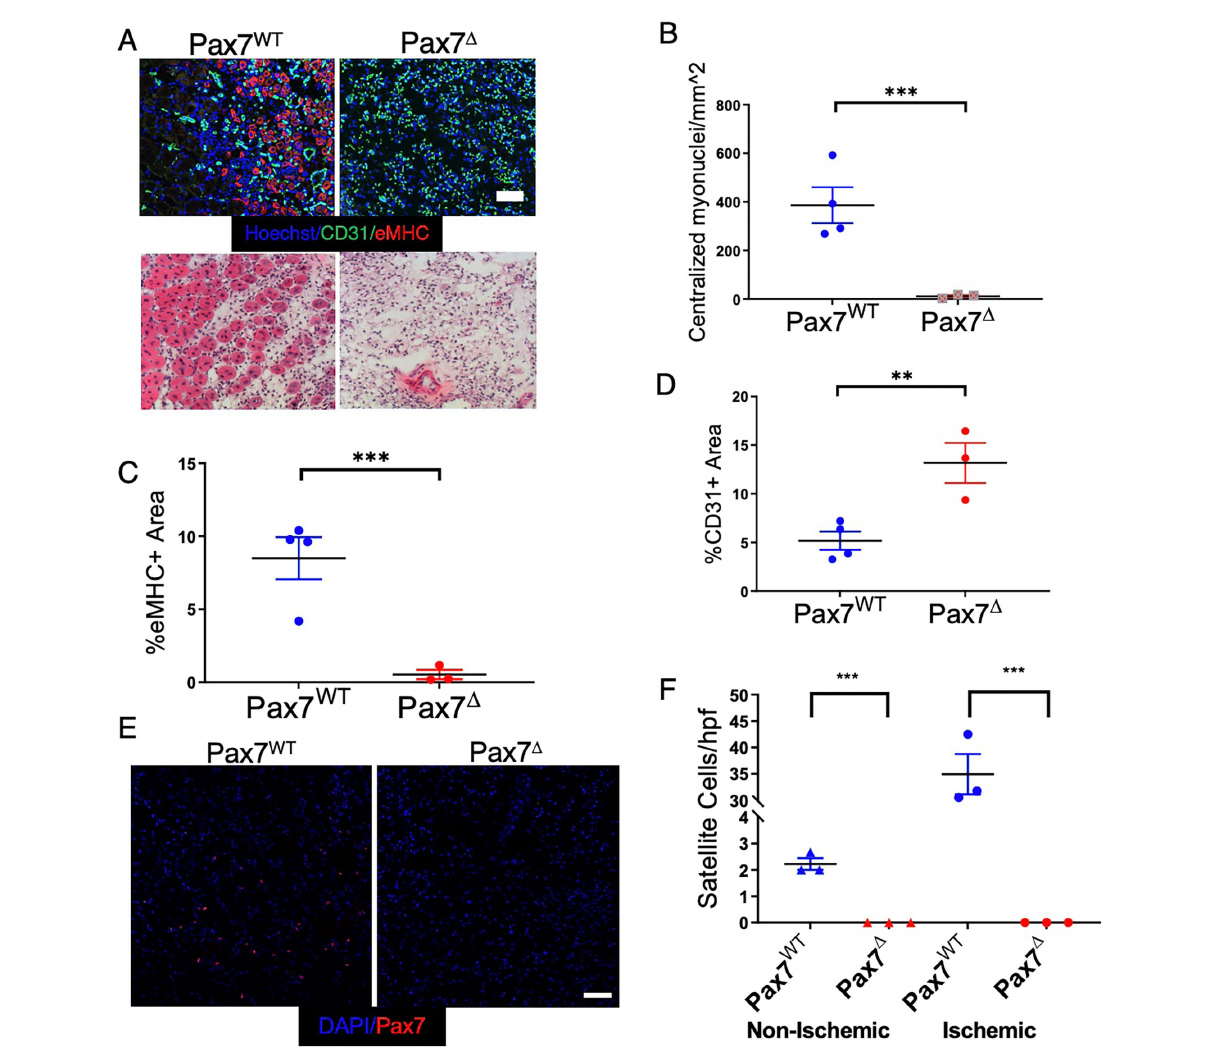
FIGURE 2 Ablation of Pax7 + MPCs in mice results in a complete lack of a muscle regenerative response 1 week after HLI. (A) Muscle regeneration was examined by staining for embryonic myosin heavy chain (eMHC, red) and endothelial cells (CD31, green), top , and for centralized myonuclei by H&E, bottom . (B–D) Quantification of centralized myonuclei (B) and eMHC (C) demonstrates a complete lack of regenerative response to ischemia. Quantification of CD31 area (D) demonstrates an increase in endothelial area relative to muscle area in Pax7 Δ mice ( n = 3–4 per group). (E,F) 1 week after HLI surgery, there was a significant increase in the number of Pax7 + cells per high power field in the ischemic TA of Pax7 WT mice but not in muscle of Pax7 Δ mice. Compared to resting muscle, there was a 10-15-fold increase in the number of Pax7 + cells in injured Pax7 WT muscle, consistent with activation of satellite cells following injury ( n = 3 per group). Scale bar = 100 μ m. All data shown are means +/ − SEM. ** p < 0.01; *** p < 0.001, by 2-sided t